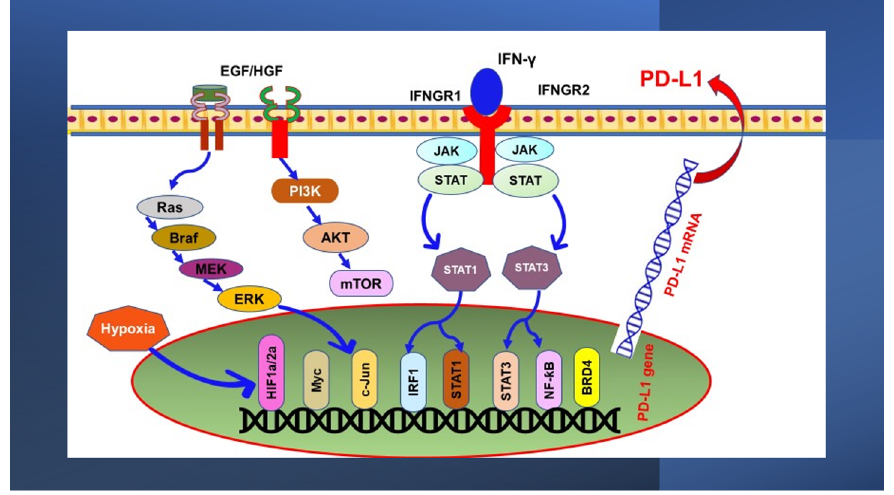
Figure 1. Tumor-intrinsic PD-L1 signaling in cancer initiation and development. The diagram highlights downstream signaling of PD-L1 activation in cancer. Hypoxia-inducible factors, HIF; interferon regulatory factor1, IRF1; MYC proto-oncogene, bHLH transcription factor, Myc; Janus kinase, JAK; signal transducer and activator of transcription (STAT)1/3; nuclear factor-kappa B, NF- ƙ B; bromodomain-containing protein 4, BRD4; interferon-gamma, IFN- γ ; IFN- γ receptor 1/2, IFNGR1/2; phosphoinositide 3-kinase, PI3K; protein kinase B, AKT; mammalian target of rapamycin, mTOR; extracellular-signal-regulated kinase, ERK; mitogen-activated protein kinase, MEK; B-Raf Serine/Threonine-Protein, BRAF; rat sarcoma, Ras; epidermal growth factor, EGF; hepatocyte growth factor HGF; programmed death-ligand 1, PD-L1.